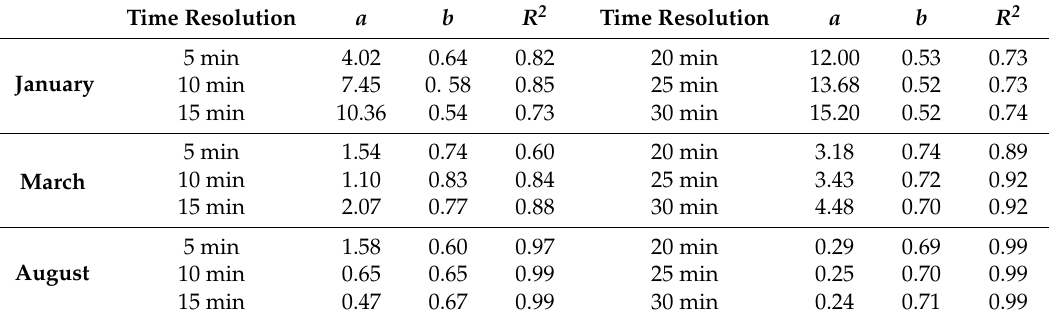
Figure 4. Allometric scaling relationship between the number of stops and POIs for activity hotspots with time resolution of 15 min in: ( a ) January; ( b ) March; ( c ) August. Table 1. Allometric scaling relationships between stops and POIs in different time resolutions for the three months (Note: All these models are statistically significant with p -values of 0 using F-test). Time Resolution